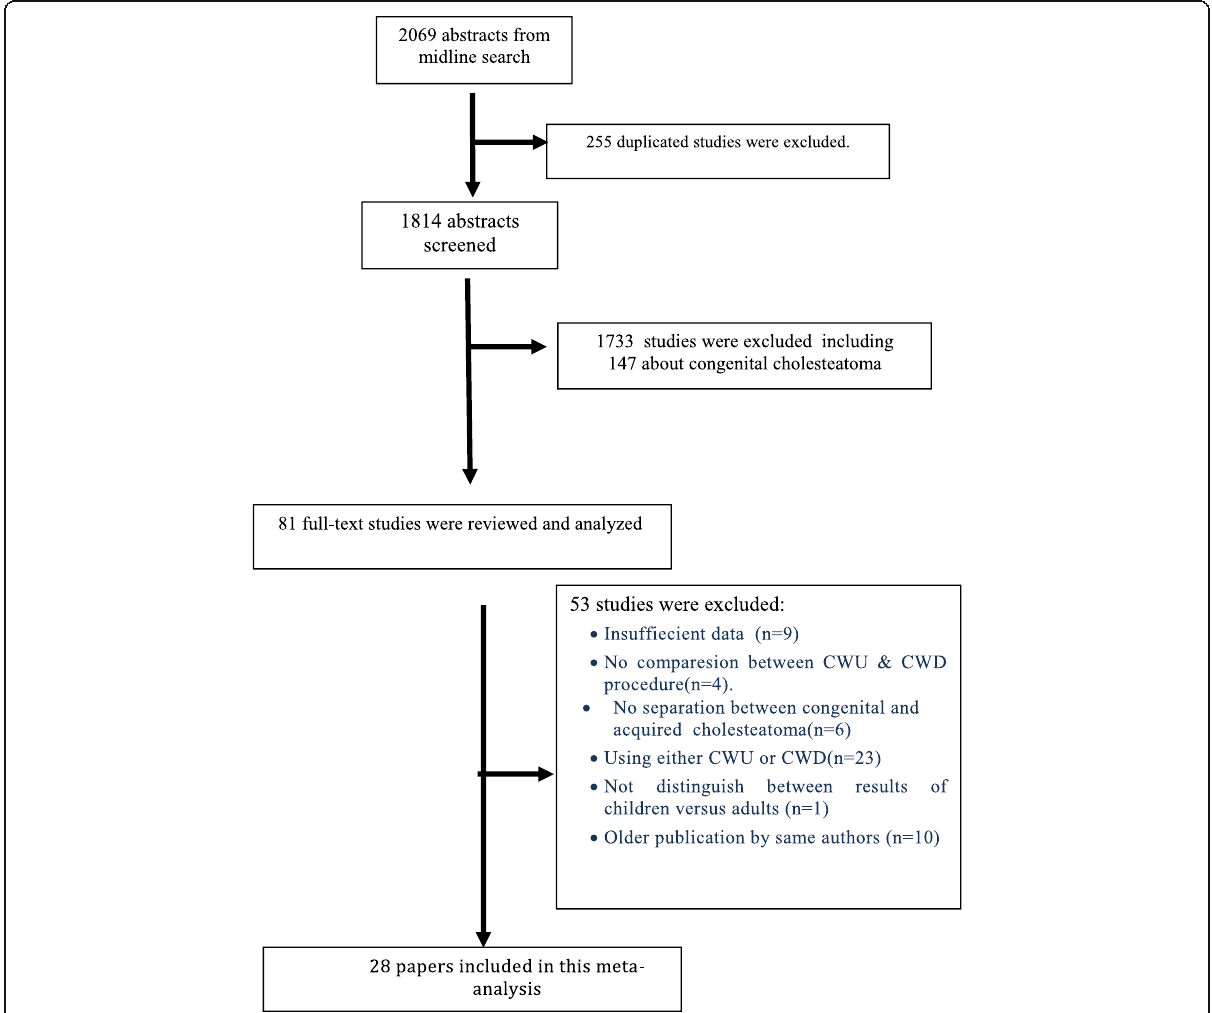
Fig. 1 Flow diagram of the included studies in the